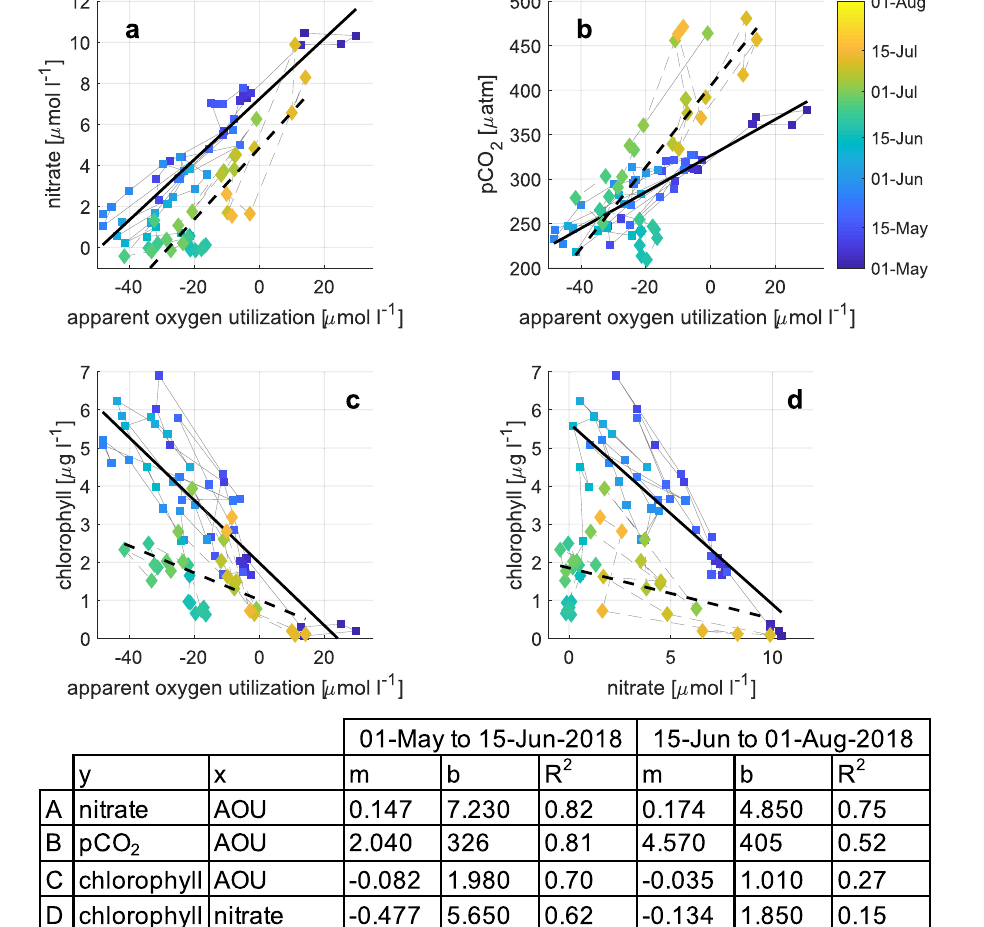
Fig. 7 Stoichiometry of bloom in mixed layer regime. Scatter plots of daily averages of apparent oxygen utilization (AOU) [ μ mol l − 1 ], nitrate [ μ mol l − 1 ], pCO 2 [ μ atm], and chlorophyll [ μ g l − 1 ] colored by date in 2018 at HG-IV. a Nitrate vs. AOU, b pCO 2 vs. AOU, c chlorophyll vs. AOU, and d chlorophyll vs. nitrate. Colored squares are data between 01-May-2018 and 15-Jun-2018 during the spring bloom. The squares are connected by gray solid lines. A least- squares regression curve is plotted as a solid black line for the time period and the regressions ’ parameters for the model y = m × x + b are given in the table at the bottom for the different parameter relations and time periods. Colored diamonds/dashed lines are the same for the time period after the bloom (15-Jun-2018 to 01-Aug-2018). Note that this analysis could not be done in 2017 as the observations were below the productive layer and no nitrate and chlorophyll observations